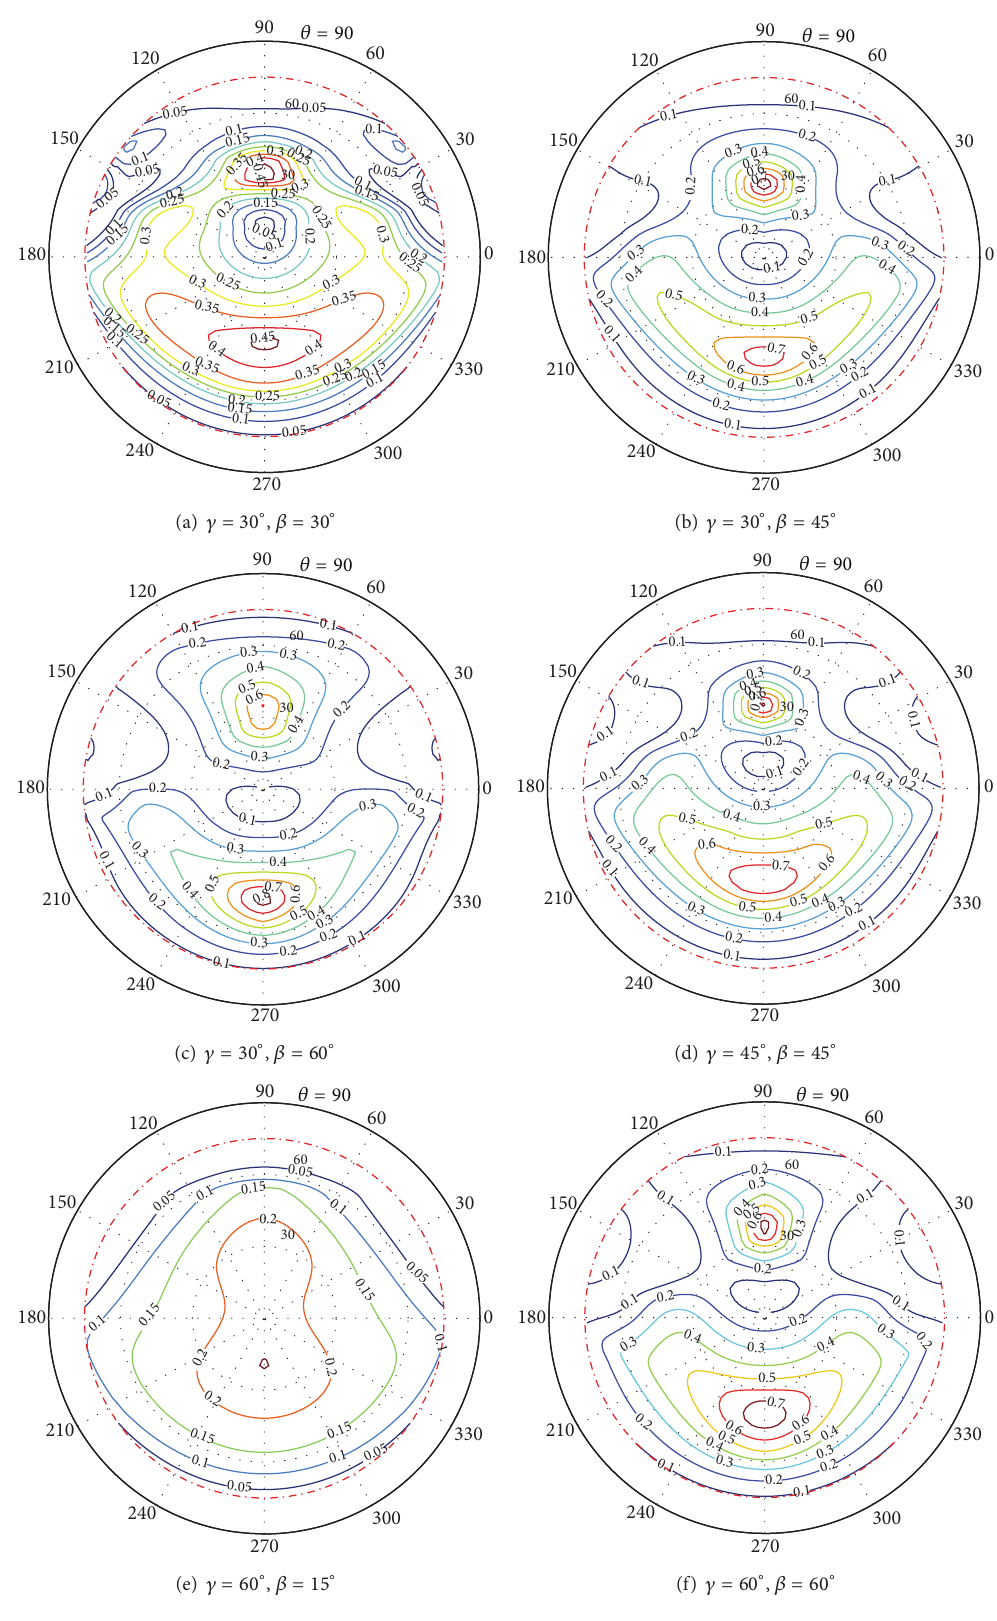
Figure 4: The dexterity distribution over the workspace with 𝜙 𝑧 = 0